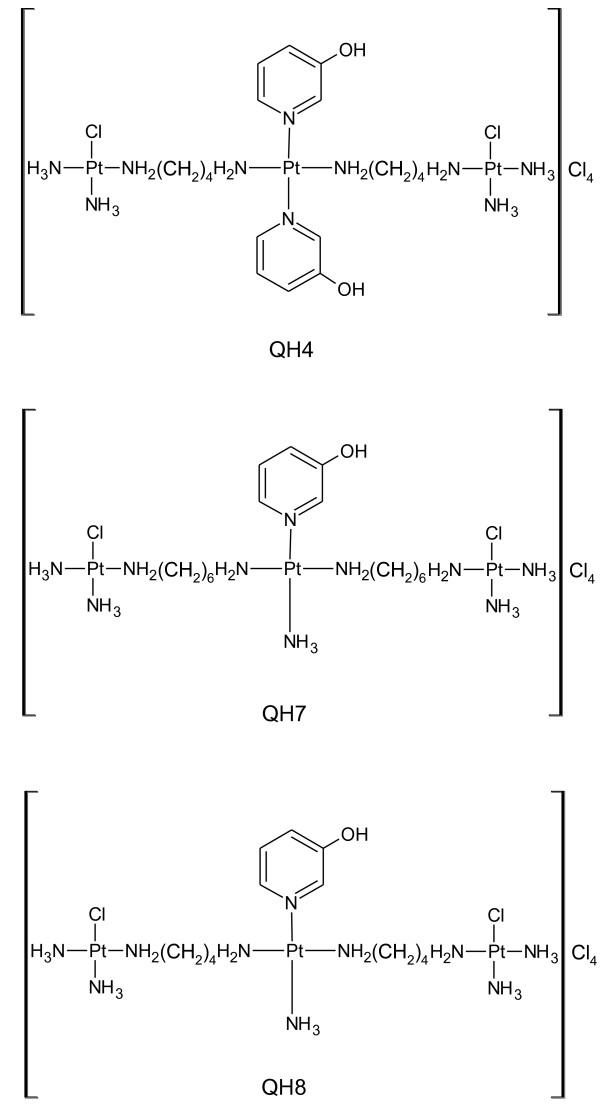
Structures of QH4, QH7 and QH8. QH2: [{cis-PtCl(NH3)2}2 μ{trans-Pt(3-hydroxypyridine)2(H2N(CH2)4NH2)2}]Cl4; QH3: [{cis-PtCl(NH3)2}2 μ{trans-Pt(3-hydroxypyridine)(NH3)(H2N(CH2)6NH2)2}]Cl4; QH4: [{cis-PtCl(NH3)2}2 μ{trans-Pt(3-hydroxypyridine)(NH3)(H2N(CH2)4NH2)2}]Cl4.